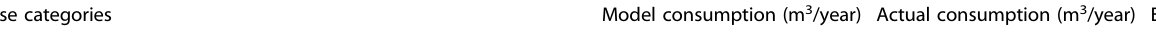
Table 1. Water use consumption validation (Girona).